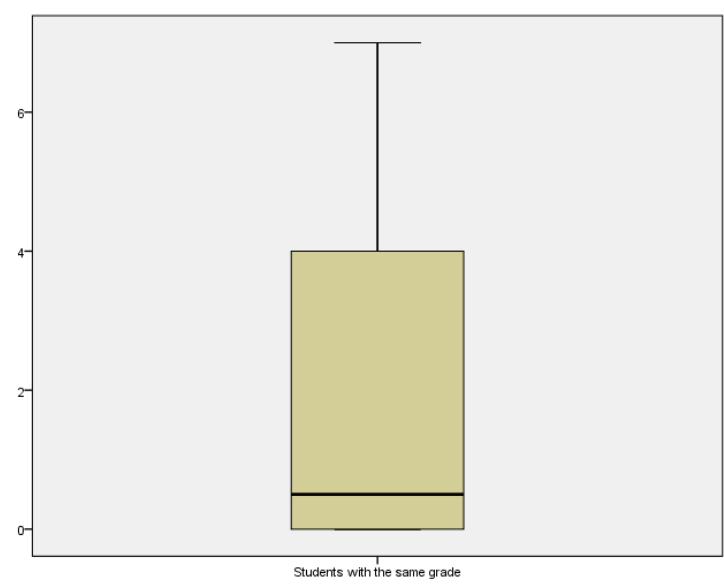
Figure 13. Box plots test for normality